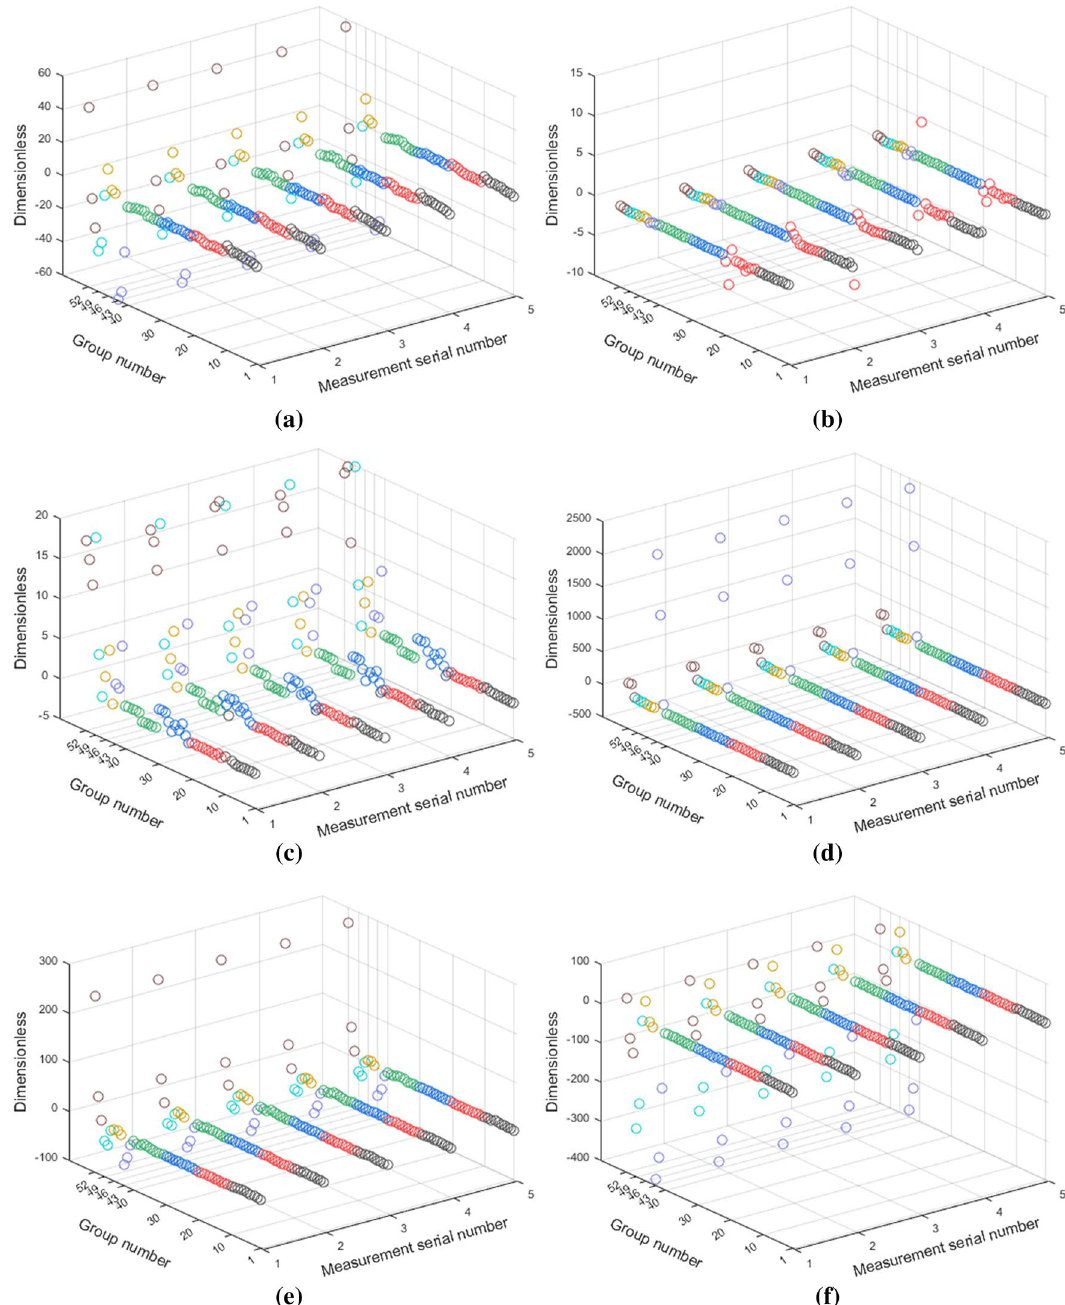
Figure 12. The indication effects of 6 characteristic indexes after standardization for different structural damages and PZT faults: ( a ) the change of resonant conductance peak magnitude (1# index); ( b ) the slope change of the susceptance linear fitting curve (2# index); ( c ) the average shift of conductance peak frequency (3# index); ( d ) the RMSD of reactance in the non-resonant frequency band (4# index); ( e ) the area change rate of conductance in the resonance frequency band (5# index); ( f ) the area change rate of conductance in the non- resonance frequency band (6# bands, four characteristic indexes were selected, including the change of resonant conductance peak magnitude, the slope change of the susceptance linear fitting curve, the average shift of conductance peak frequency, and the RMSD of reactance in the non-resonant frequency band. The average shift of peak frequency refers to the average shift of the five bands (30–200 kHz, 200–400 kHz, 400–600 kHz, 600–800 kHz, 800 kHz–1 MHz) divided from the test frequency range to avoid inaccurate result caused by the improper selection of frequency range. Another two indexes, the area change rate of conductance in resonance and non-resonance frequency band were also